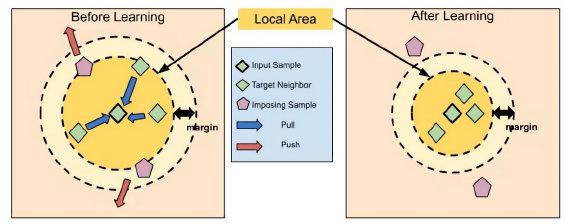
Figure 4. The procedure of LMNN Distance Metric Learning